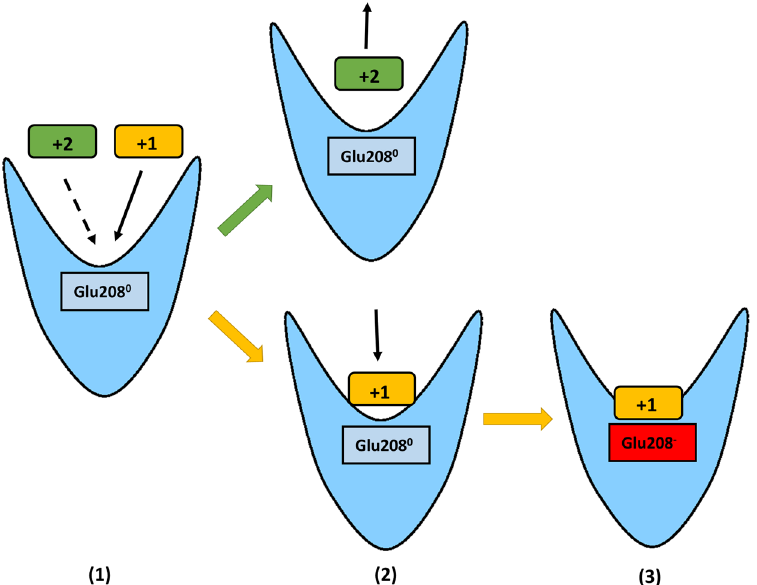
Figure 5. Schematic overview of ligand selection by the AdiC binding site. ( 1 ) Under acidic conditions, during migration of the divalent (green box) or monovalent (orange box) ligand to the binding site, Glu208 0 (light blue rectangle) remains protonated. Note here that migration should be less likely for the divalent compounds since their affinity for the aqueous periplasm is higher than that of Arg + as suggested by the dashed arrow. ( 2 ) Glu208 0 favors tight binding of monovalent Arg + and drives away divalent Arg 2 + and Agm 2 + , which remain more hydrated and are released on the outside. ( 3 ) Arg + enters more deeply into the binding site and shields Glu208 from the acidic medium. This promotes the deprotonation of Glu208, followed by tighter binding of Arg + , which then forms specific direct and mediated